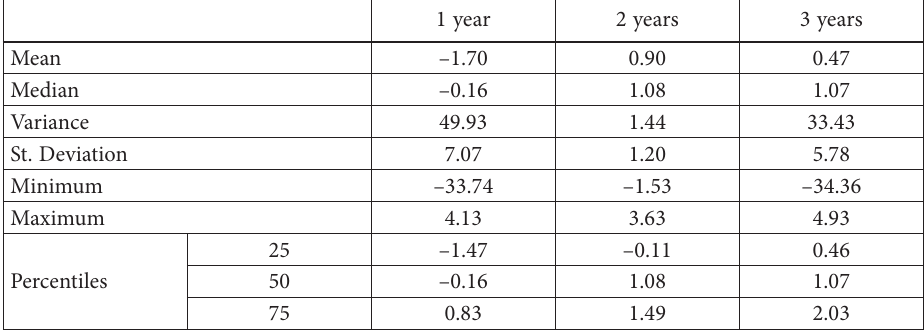
Table 5. Results of Altman Z -Score (source: authors based on financial